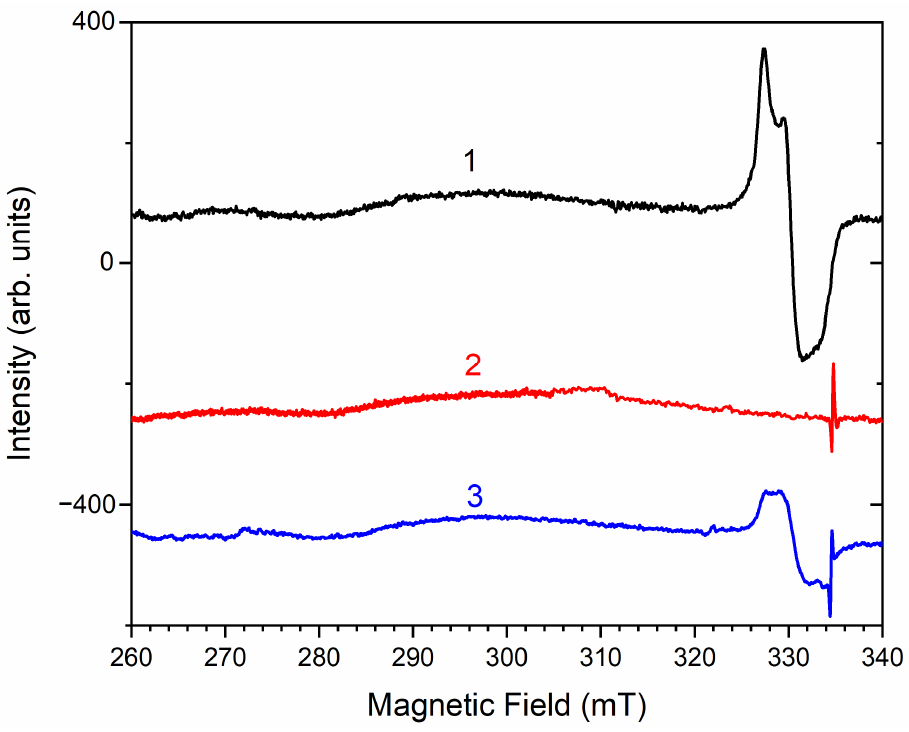
Figure 17. ESR spectra of initial haüyne (Sample 2) (1), and Sample 2 heated at 700 ◦ C under buffer (2) and at 800 ◦ C in air (3).